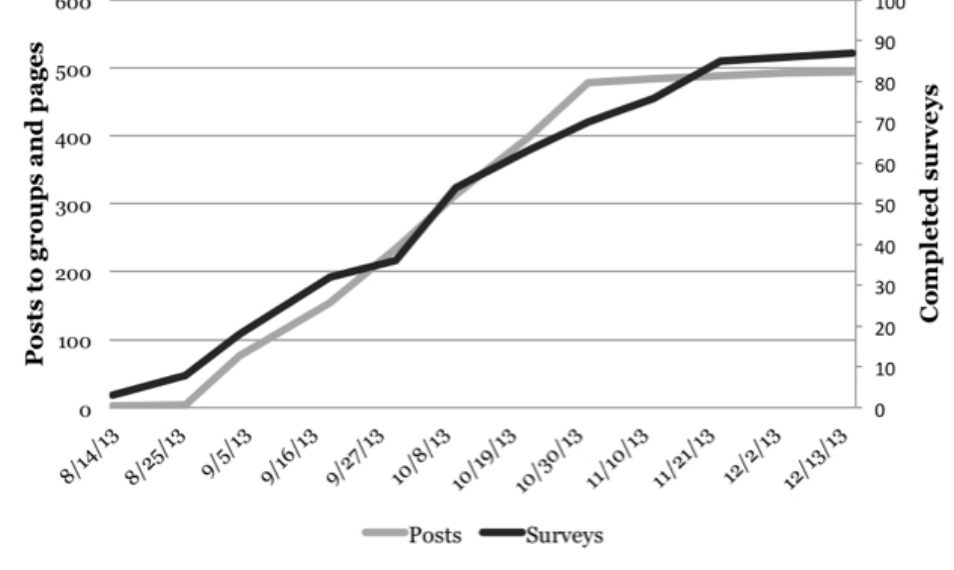
Figure 5. Study 1 cumulative recruitment over